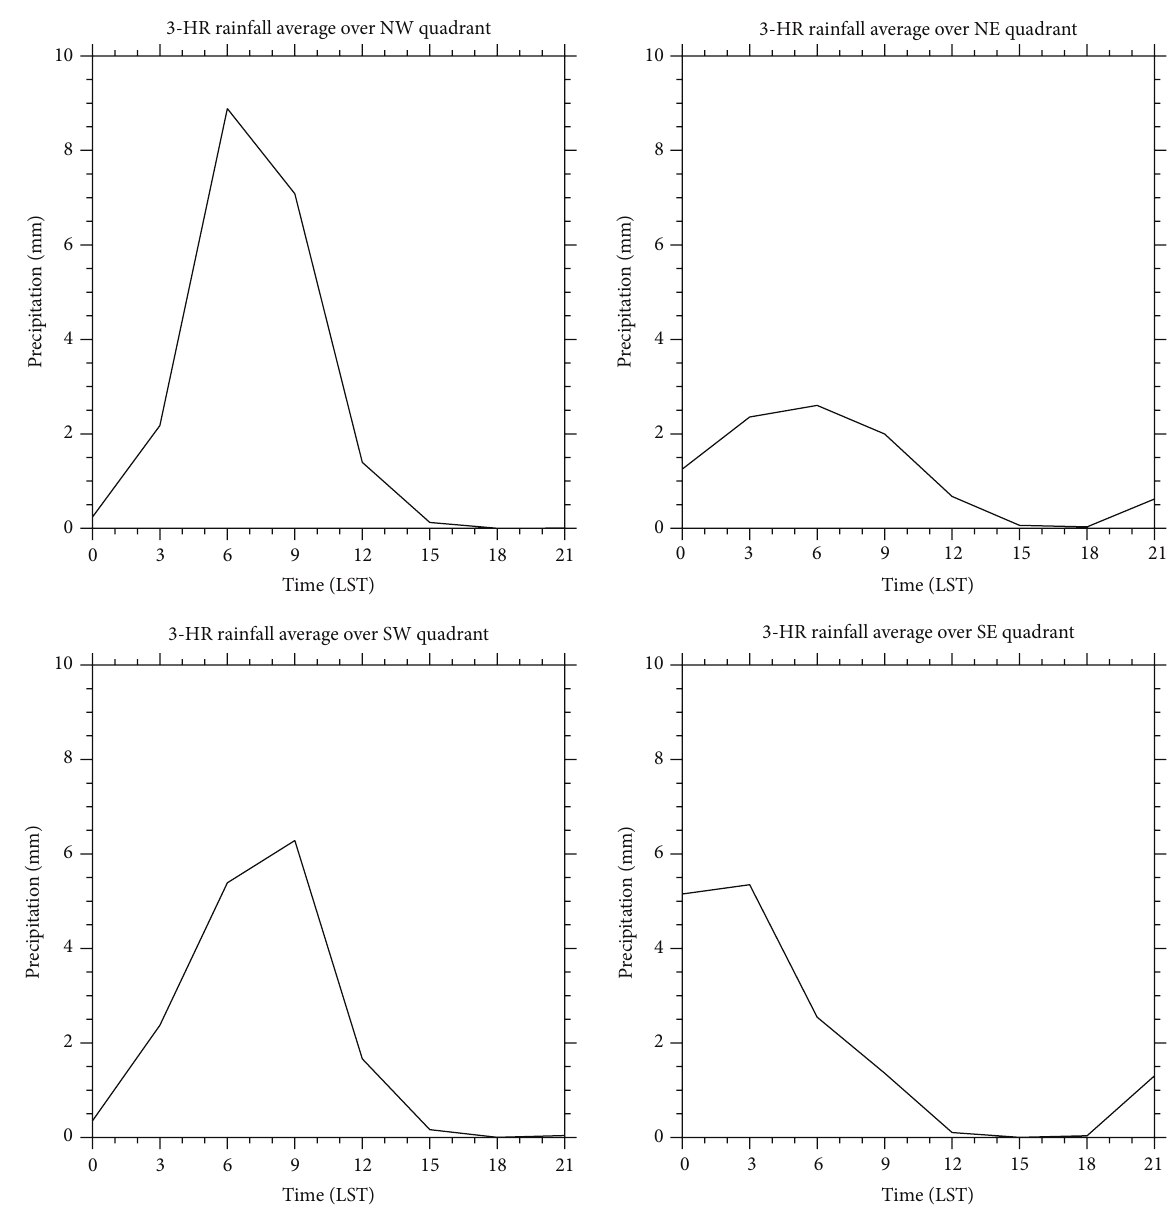
Figure 11: Time series of 3-hourly total rainfall over four quadrants of the